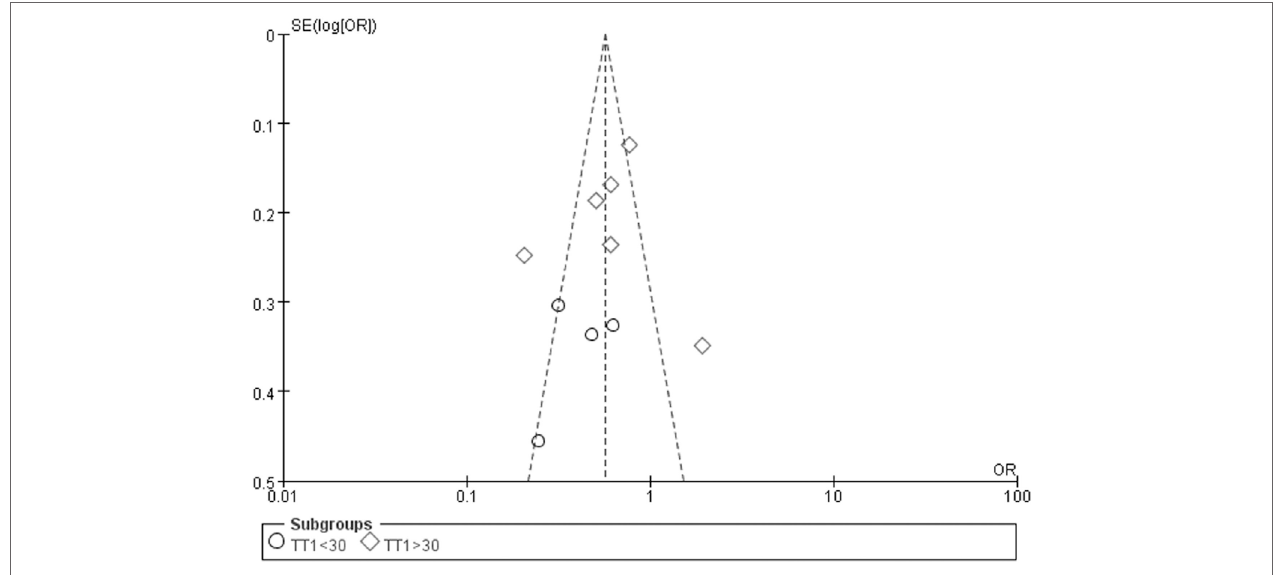
FiGURe 8 | Funnel plot for studies of type 2 diabetes mellitus associated with SLC30A8 gene rs13266634C/T in the Chinese population under a recessive genetic model (TT vs. CT + CC). The horizontal and vertical axis correspond to the OR and confidence limits. Abbreviation: OR, odds